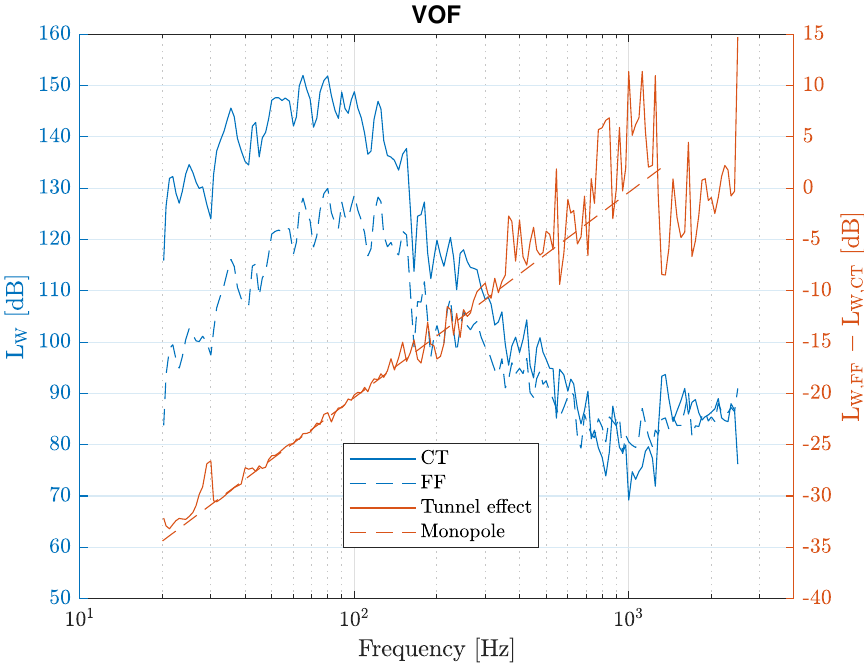
Figure 31. Sound power levels and correction terms for the cavitator test case (VOF solution) in cavitation tunnel (CT) and in free field